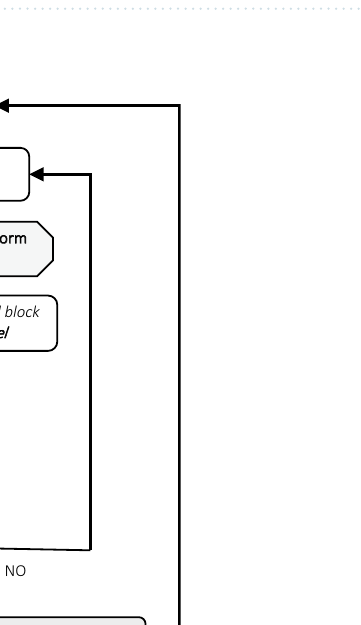
Figure 4. D-PNN searches for the optimal 2-input node in each layer to produce neurons or CTs in the blocks to be included in the output sum.